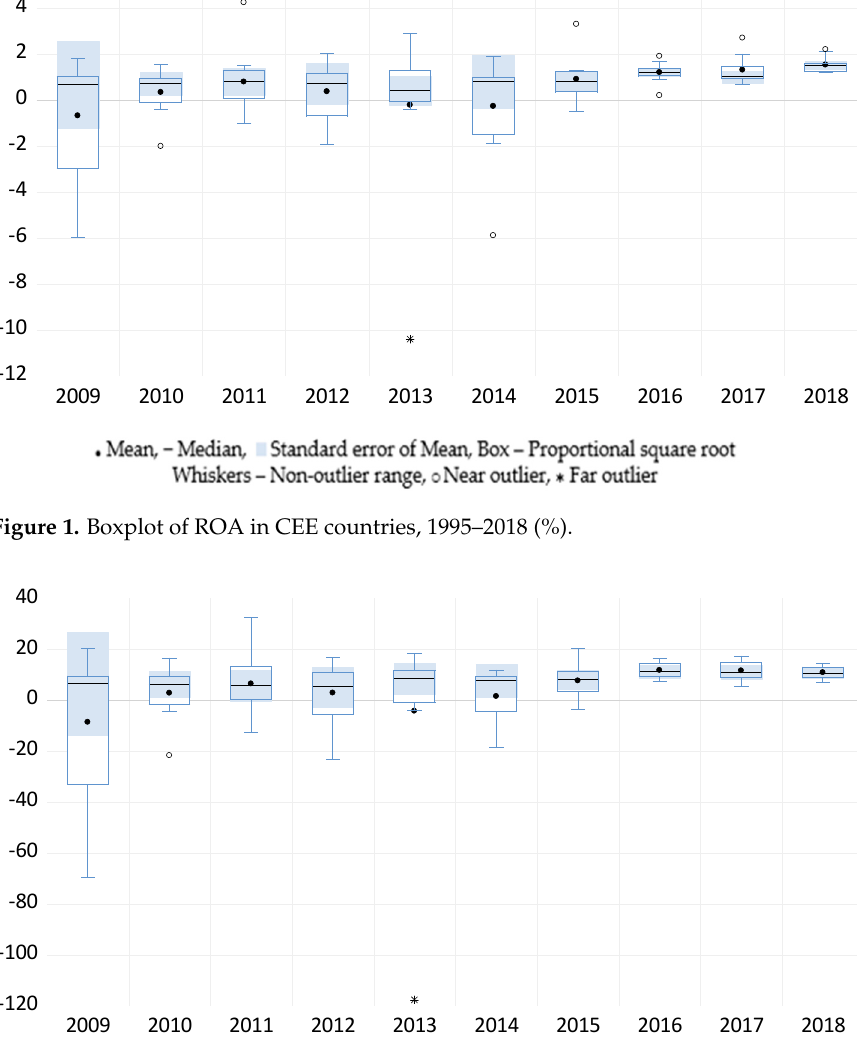
J. Risk Financial Manag. 2021 , 14 , x FOR PEER REVIEW 11 of 25